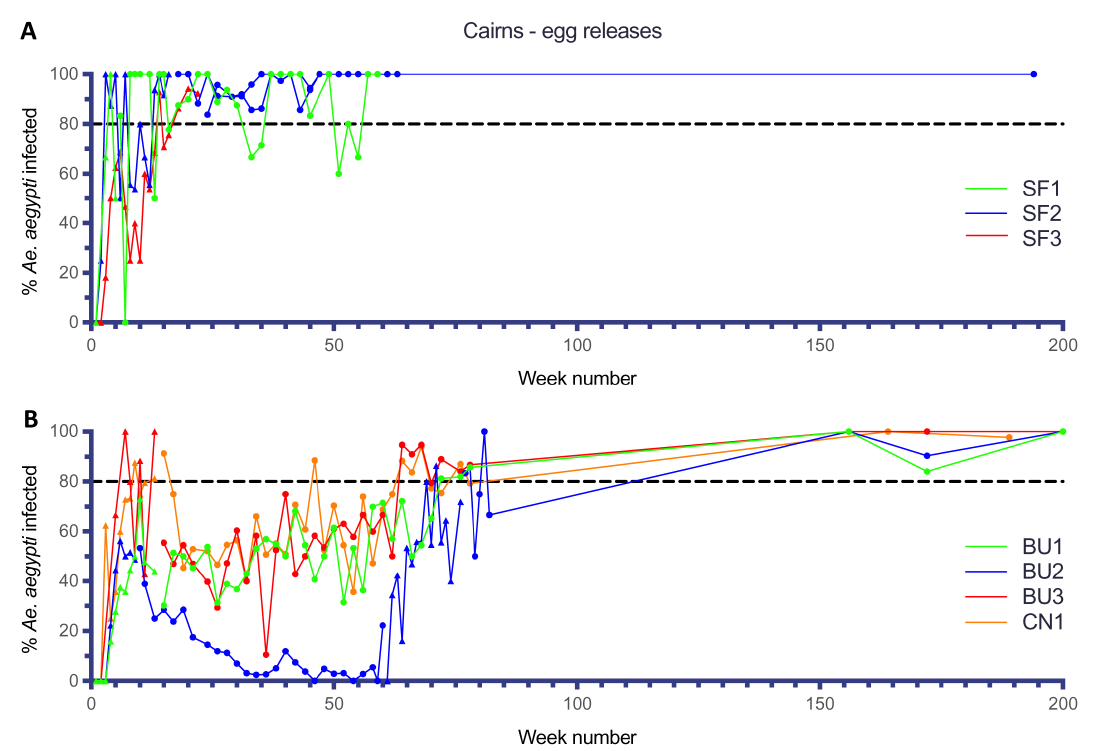
Figure 8. Wolbachia infection rates in Aedes aegypti mosquitoes collected from Stratford 1-3 (SF1-3) ( A ) and Bungalow 1-3 (BU1-3) and Cairns North (CN) ( B ) and during release (triangles) and post-release (circles) monitoring periods ( Wolbachia infected egg releases were undertaken weekly for 4, 16 and 19 weeks in SF1-3, respectively, from Jun–Nov 2014, and for 12 and 13 weeks in BU1 and BU3, respectively, from Aug-Oct 2014; BU2 had two rounds of egg releases – 8 weekly releases from Aug–Sep 2014, followed by 12 weekly releases from Oct–Dec 2015, Week number 1 corresponds to commencement of Wolbachia mosquito releases in each